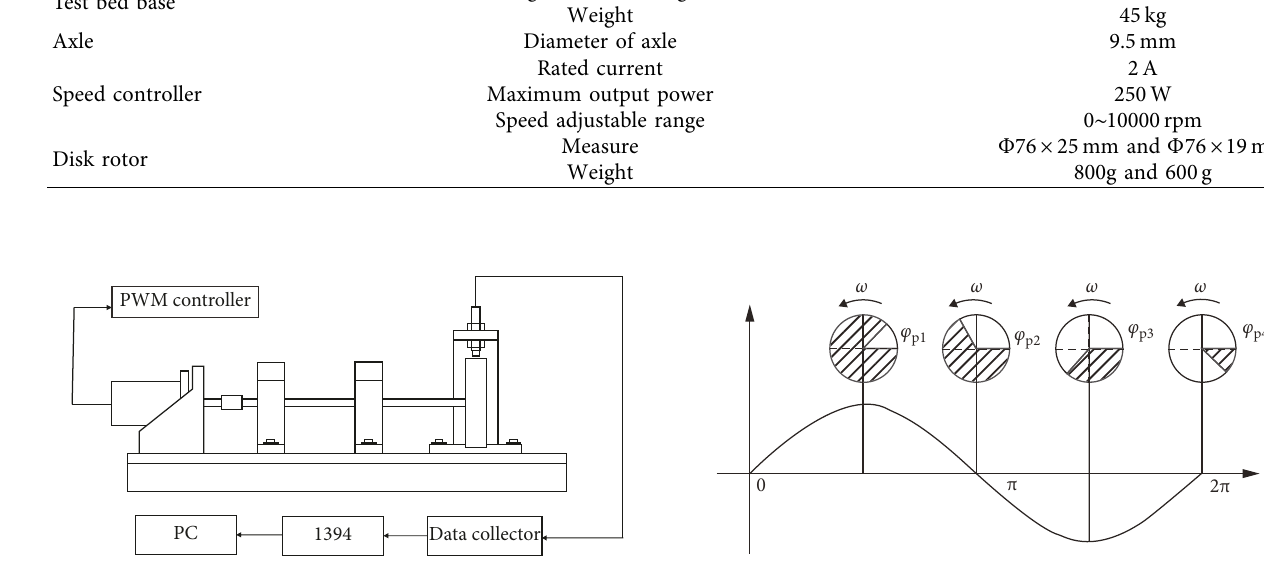
Figure 11: Test bench test system connection diagram.